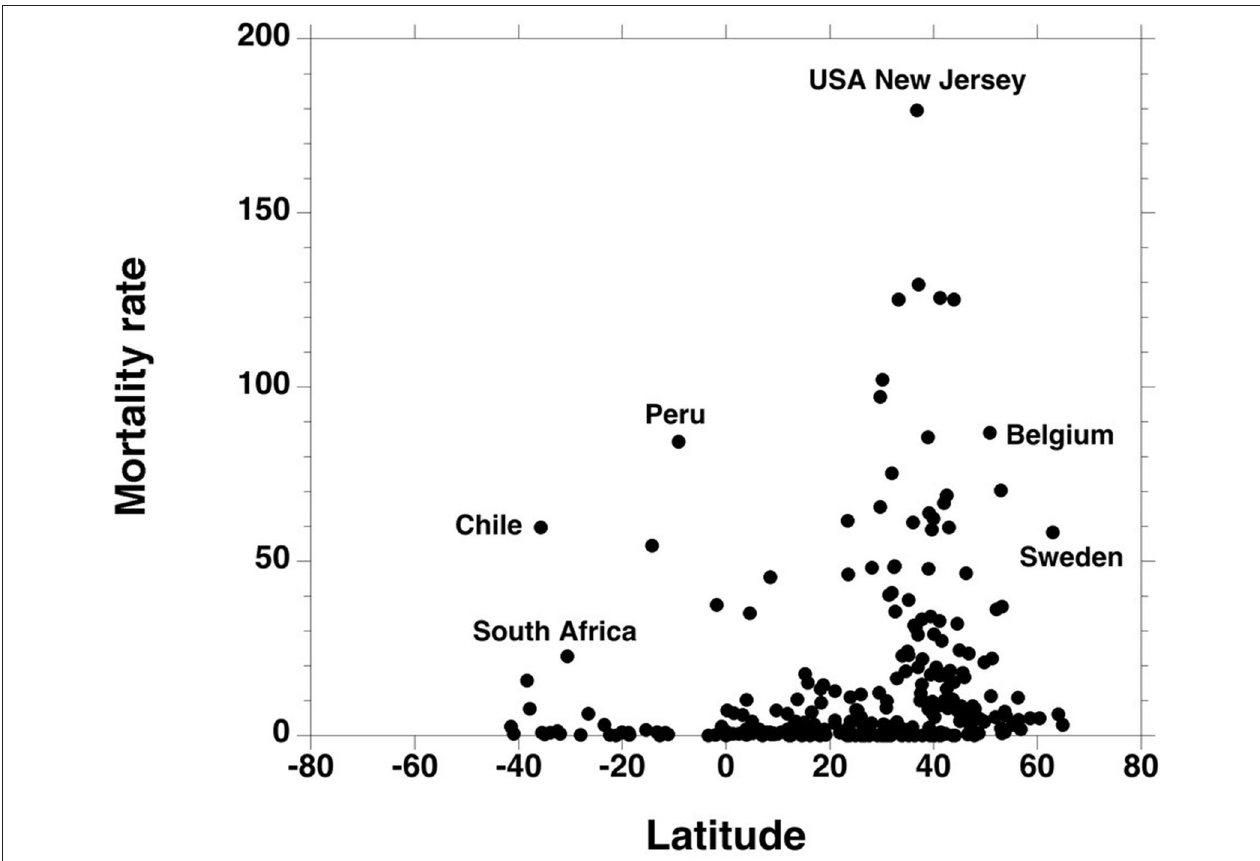
FIGURE 1 | Each point represents the Covid-19 mortality rate of a country or a state, according to its latitude. Greater mortality rates were mostly observed in the [25 /65] latitude